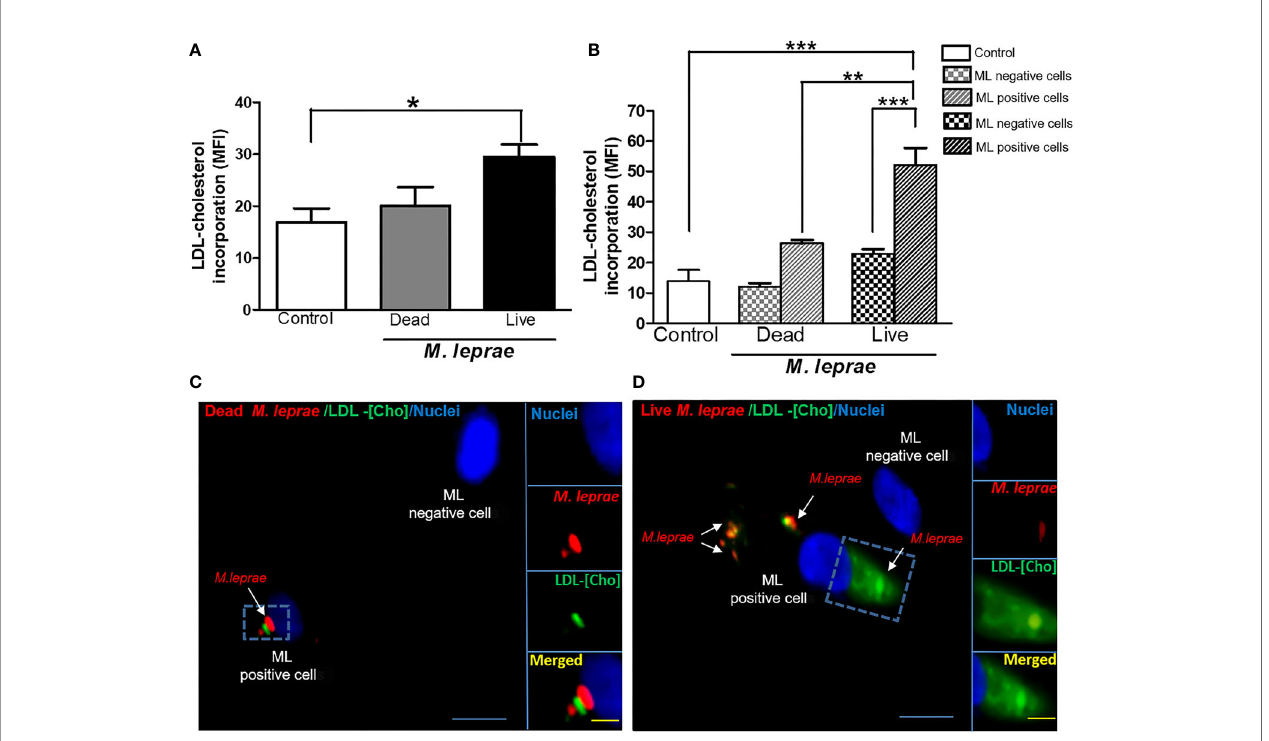
FIGURE 1 | M. leprae -infected human SCs display increased uptake of LDL-cholesterol. ST88-14 human SC line was incubated with PKH26-labeled (red) M. leprae (ML) at a MOI of 50:1 for 48 h, followed by 2 h incubation with LDL-[Cho] (green). (A, B) LDL-[Cho] incorporation and bacterial association was measured simultaneously by fl ow cytometry and is expressed as medium fl uorescence intensity (MFI). Results from three representative experiments are shown. Statistically signi fi cant differences (*p < 0.05 by Student ’ s t-test statistical analyses) (** p< 0.01 and ***p < 0.0001 - ANOVA test followed by Bonferroni as a post-test were performed and used for statistical analyses). (C, D) Confocal microscopy images showing LDL-cholesterol (green) incorporation in stimulated and infected cells. Dead and live M. leprae are labeled in red with PKH26 and nuclei are labeled in blue with DAPI. Arrows indicate colocalization of LDL-[Cho] with M. leprae . Scale bar, 5µm (blue) and 10µm